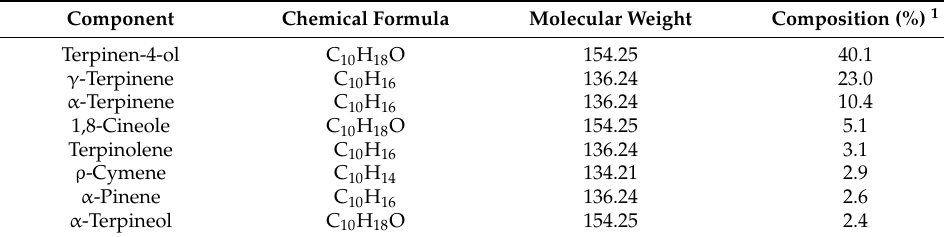
Table 3. Major components of M. alternifolia oil.